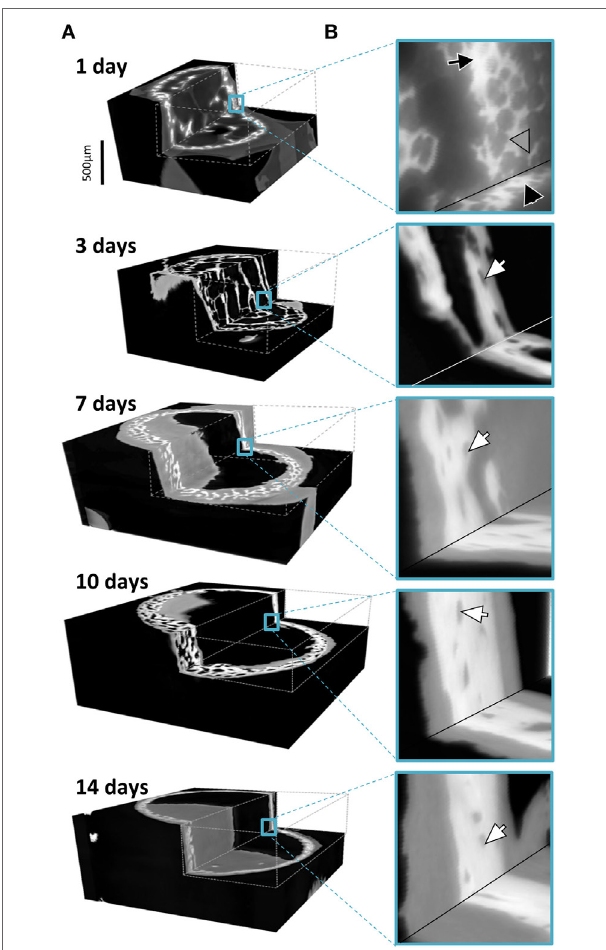
FigUre 5 | Density assignment and 3D mapping of the soft and hard tissues in the forming mouse femur in 3D. (a) The soft tissue colorized in blue surrounds and comes into intimate contact with mineralized bone, colorized in green. Islands of high mineral density exceeding 1.9 g/cm 3 are shown in red, better observed in the high-magnification insets in (B) .